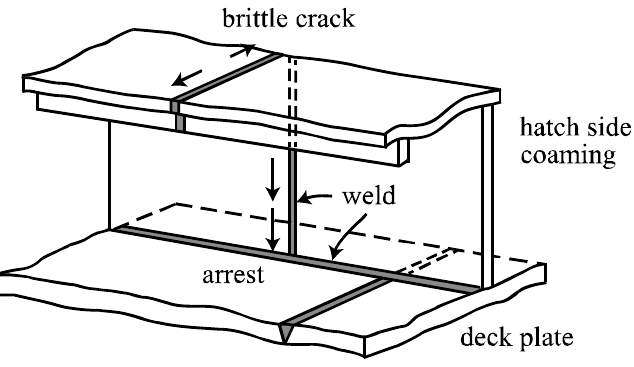
Figure 13: An example of brittle crack arrest in a deck